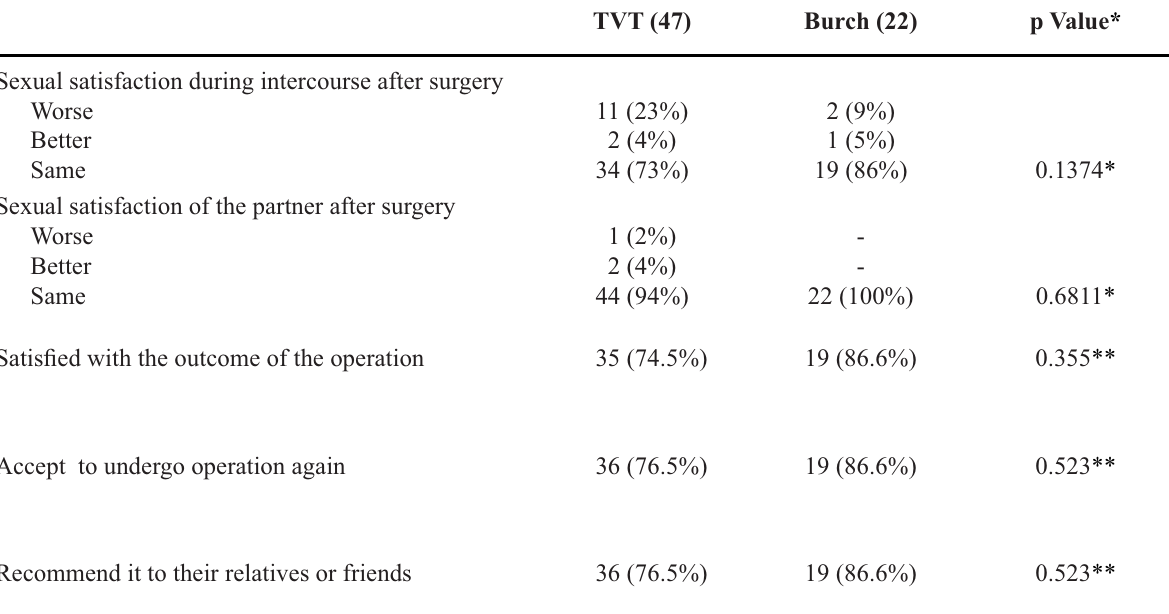
* = chi square; ** = Fisher exact test.